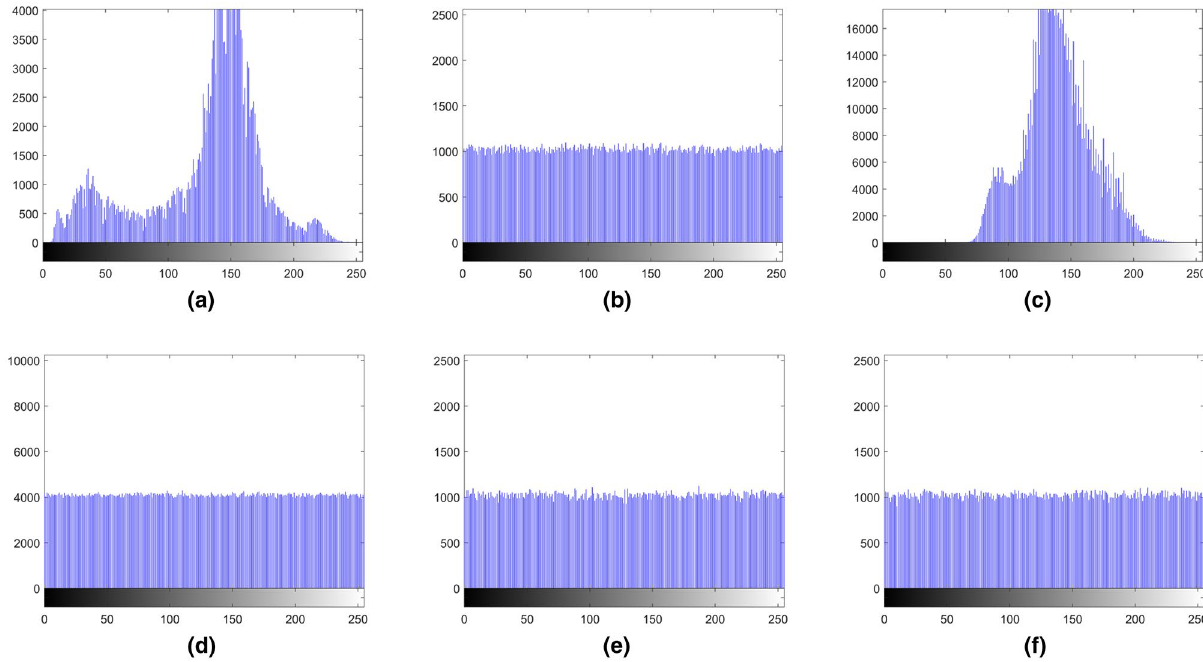
Figure 13. The histograms of gray images and encrypted images. ( a ) Histogram of Boat.512, ( b ) histogram of encrypted Boat.512, ( c ) histogram of image 3.2.25, ( d ) histogram of encrypted image 3.2.25, ( e ) histogram of encrypted White, ( f ) histogram of encrypted